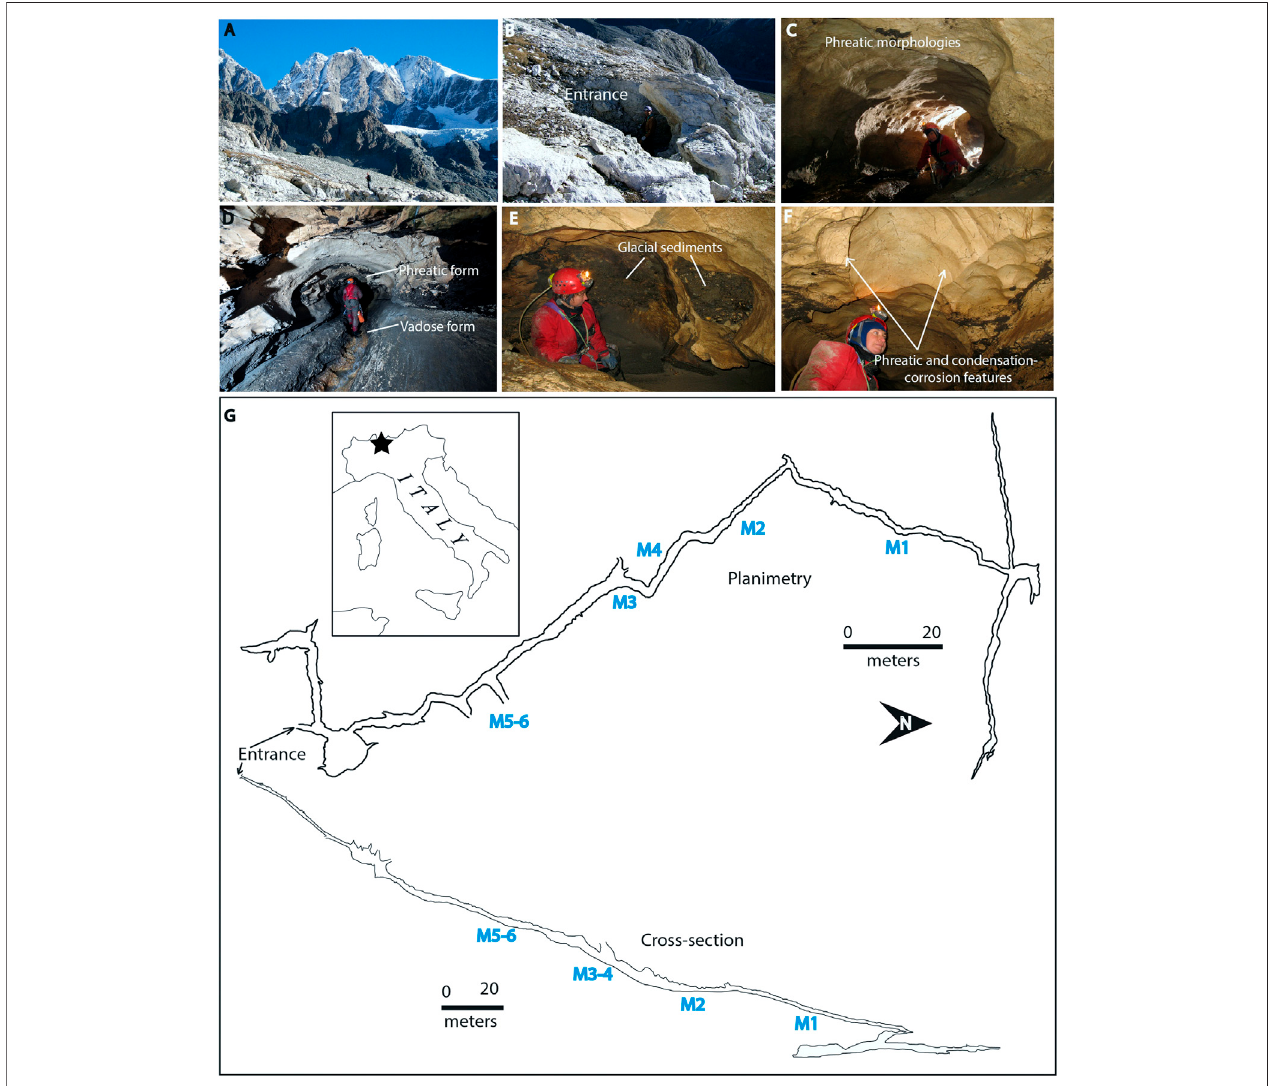
FIGURE1 | Morgana Cave. (A) Panoramic view ofthecaveslocation; (B) Entrance partiallycovered by snow; (C) Phreaticmorphologies; (D) Phreaticand vadose morphologies (sampling site M1); (E) Glacial sediments; (F) Phreatic and condensation-corrosion features; (G) Planimetry and cross-section of the cave. The six sampling sites from the innermost M1 to the outermost zone M5-M6 have been indicated on the map. Photos (A) and (B) by A. Granati, photos (C – F) by M. Inglese. Planimetry from Gruppo Grotte Milano.